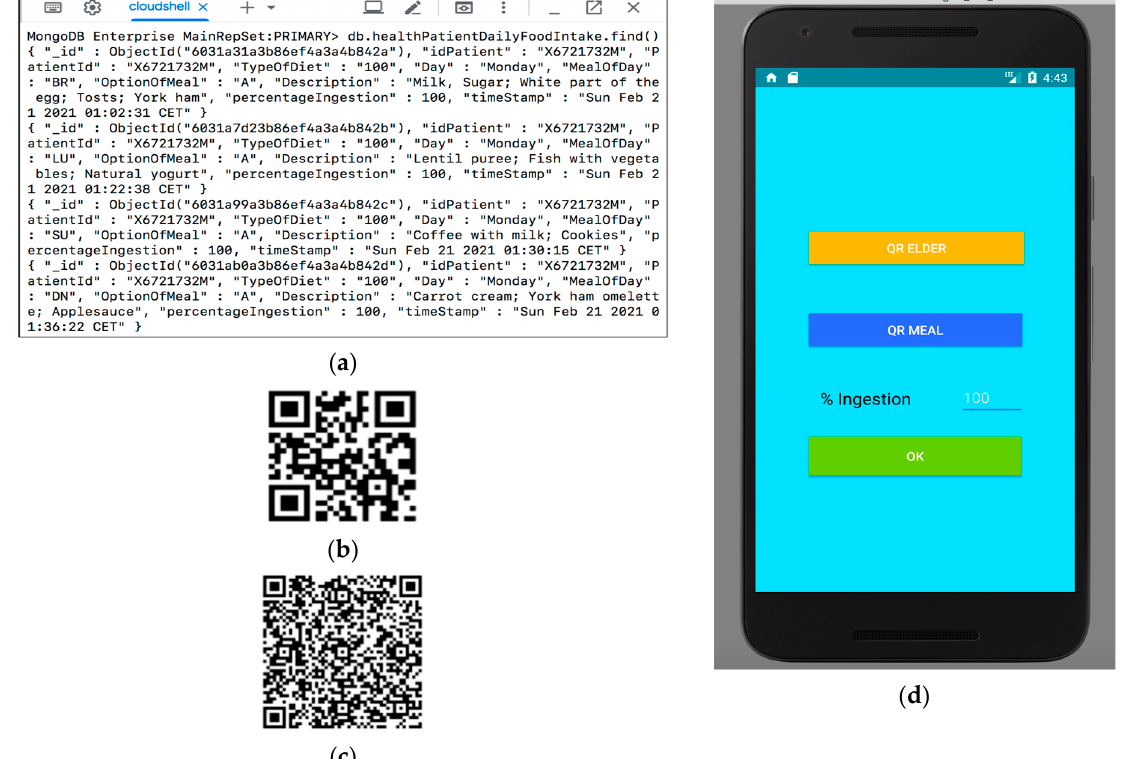
Figure 11. ( a ) Messages from food intake monitoring and sent to the system. ( b ) Example of QR codes related to the elderly person’s identification. ( c ) Example of QR codes related to food identification. ( d ) Smartphone interface for capturing food intake.